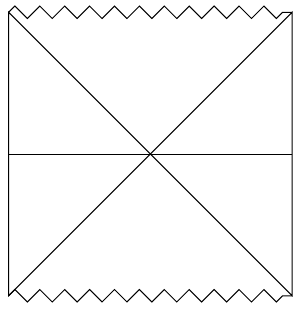
Figure 23 . Thermo-field double state and the Penrose diagram for the dual AdS-Schwarzschild geometry. The horizontal line in the middle represents the t = 0 time